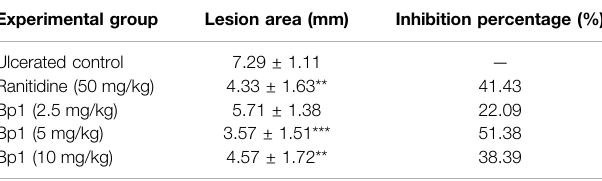
TABLE4| EffectofpretreatmentwithBp1(2.5,5,and10 mg/kg)inthelesionarea and percent inhibition in the indomethacin-induced model. Experimental group